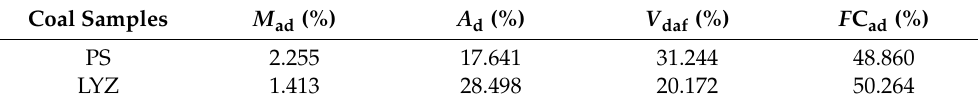
Table 1. Basic parameters of